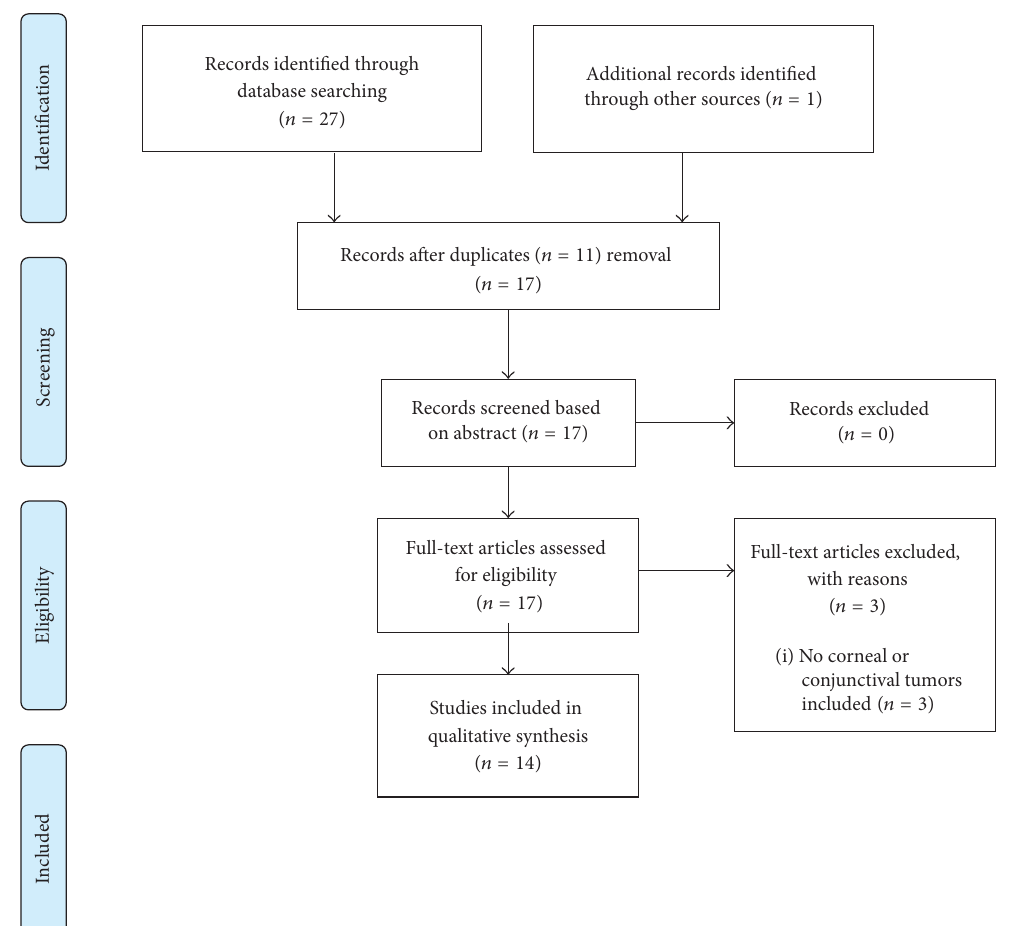
Figure 1: Flow diagram of literature